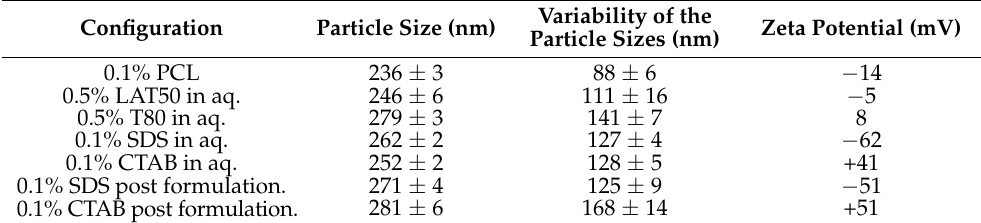
Table 5. Particle sizes and zeta potential of particles prepared in the presence of